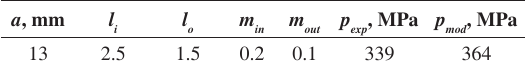
Table 1. Data used in experiment and modeling of ECAE and resulting pressures.